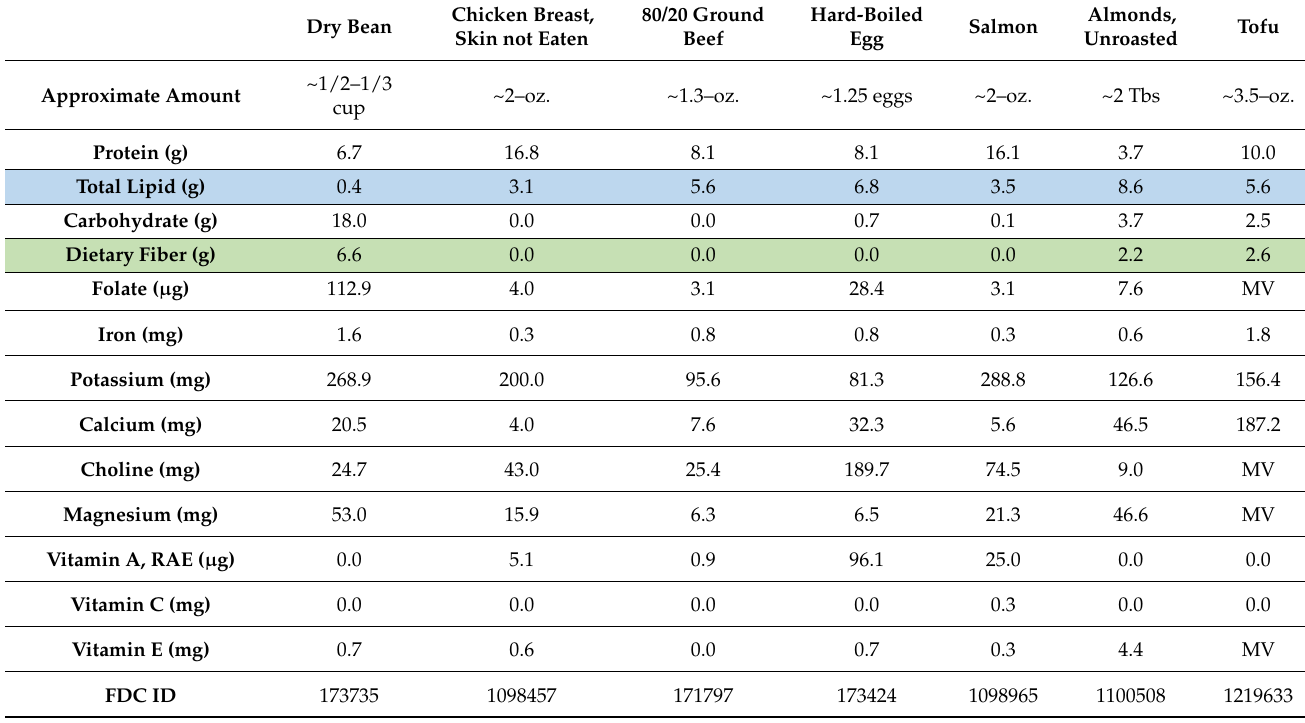
Table 3. Nutritional analysis of 100 kilocalorie portions of dry bean versus other protein foods.